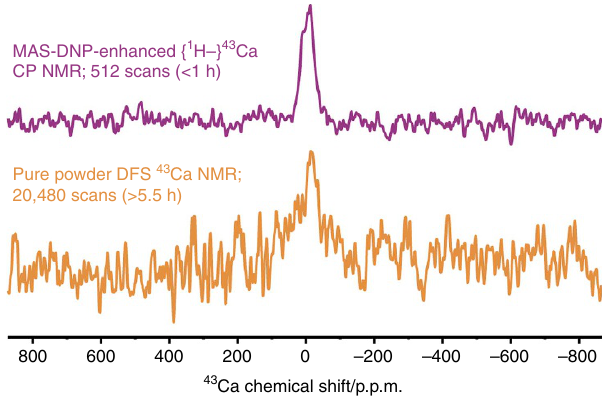
Figure 3 | 43 Ca MAS NMR spectra of C–HAp. Both were recorded at B 100K, 9.4Tand using a MAS rate of 8.5kHz. Direct CTexcitation of 43 Ca after DFS of the pure powder (orange) is compared with the DNP-enhanced { 1 H–} 43 Ca CP experiment (purple), recorded using a CP contact time of 5ms. Note that the time required to obtain much greater S/N with the DNP-enhanced experiment was o 1/5 compared with the conventional method; the experimental time-saving with the DNP-enhanced experiment is a factor of